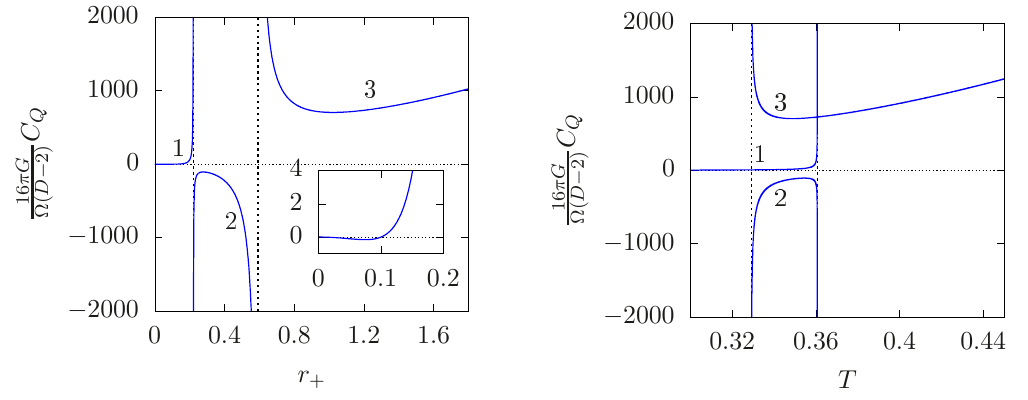
Figure 3 . Plots of C Q vs. r + (left) and C Q vs. T (right). The parameter choices are the same as for (cid:12)gure 2.